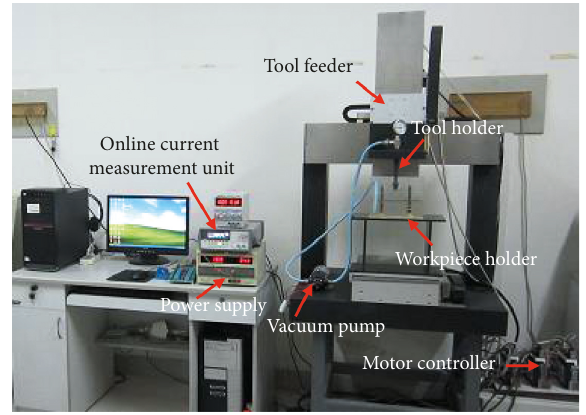
Figure 2: Experimental setup of the STEM